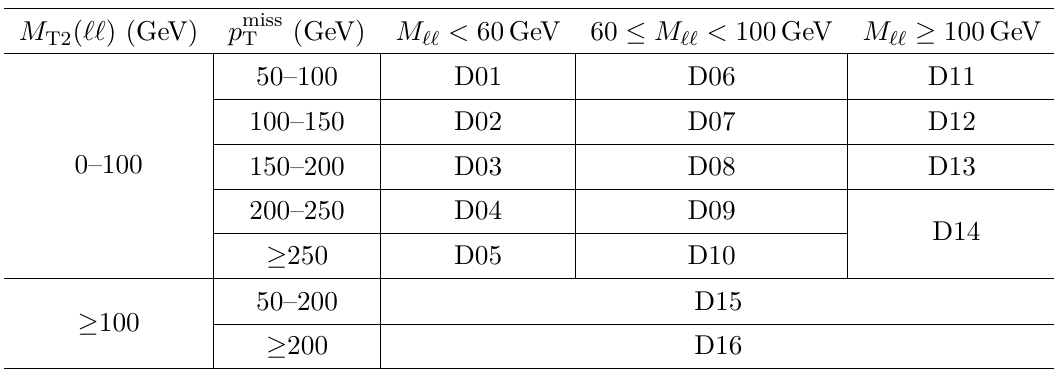
Table 7 . Definition of the search regions for events with a e ± m ∓ pair and a t